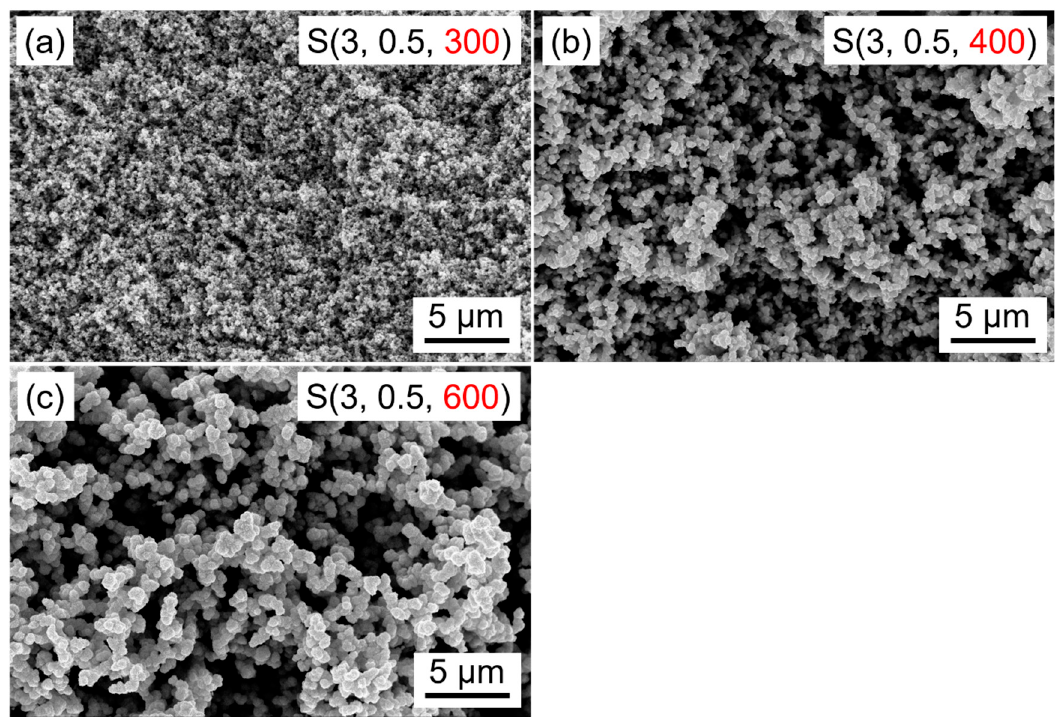
Figure 9. Scanning electron microscopy images of WO 3 films prepared at different calcination temperatures. ( a ) 300 °C, ( b ) 400 °C, ( c ) 600°C.